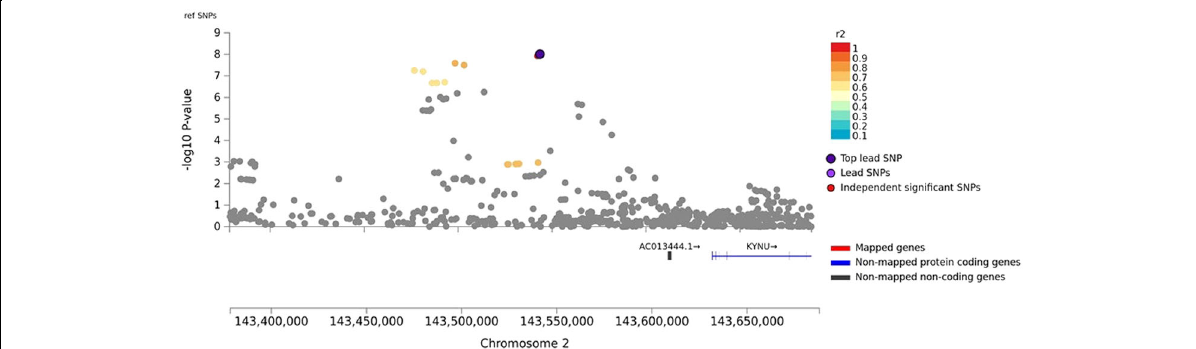
Fig. 1 Association of stimulant dependence with SNPs located between LRP1B and KYNU in the African American discovery sample. SNPs are color-coded according to the correlation coef fi cient ( r 2 ) in the 1000 Genomes African reference panel with the top-ranked SNP, rs6721393. Rs6721393 was nearly genome-wide signi fi cant ( P = 3.13 × 10 − 7 ) after meta-analysis with the replication sample.